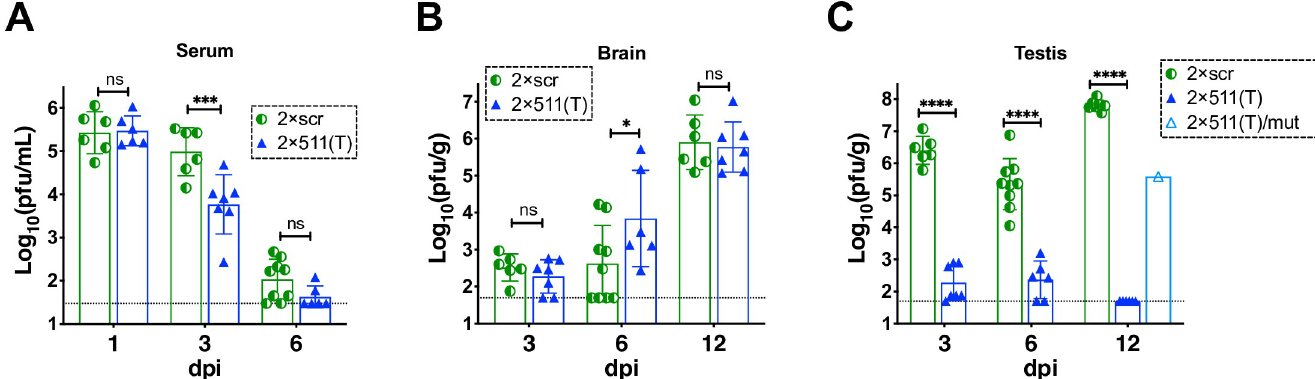
Fig 2. Effect of mir-511-3p target insertions on ZIKV replication in the serum, brain and testes of AG129 mice. Adult AG129 male mice (n = 6–9 per group) were infected IP with 10 6 pfu of ZIKV clones containing target sites for mir-511-3p [2 × 511(T)] or scrambled target sites [2 × scr]. Mice were bled and/or sacrificed at the indicated days post infection. Mean viral titer ± SD in the serum ( A ), brain ( B ), or testes ( C ) was determined by titration in Vero cells. The dashed lines indicate the limit of virus detection: 1.5 log 10 pfu/mL of serum ( A ) and 1.7 log 10 pfu/g of brain or testis ( B-C ). Differences between the virus titers were compared using two-way ANOVA ( ���� p < 0.0001; ��� p < 0.001; � p < 0.05; ns—denotes not significant, p > 0.05). Except 6 dpi, all data for the 2 × scr virus are retrospective [17] and provided here for comparison. Data for 6 dpi for the 2 × scr virus was combined from the data reported earlier (n = 6) [17] and newly generated results (n = 3). Viral RNA was isolated from the serum at 1 dpi, brain at 12 dpi and testes at 12 dpi, and the region containing miRNA targets was sequenced. If mutation/deletion was detected in the miRNA targeted region, viral titer for these samples was reported under the name 2 × 511(T)/mut.